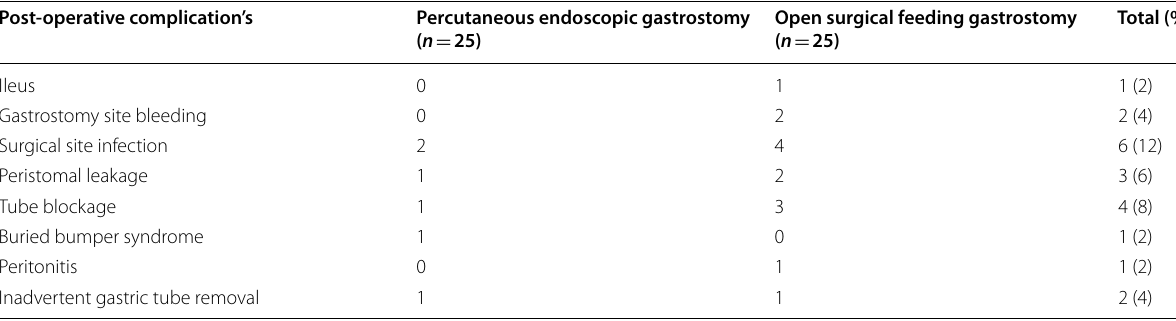
Table 2 Comparison of post-operative complications Post-operative complication’s Percutaneous endoscopic gastrostomy